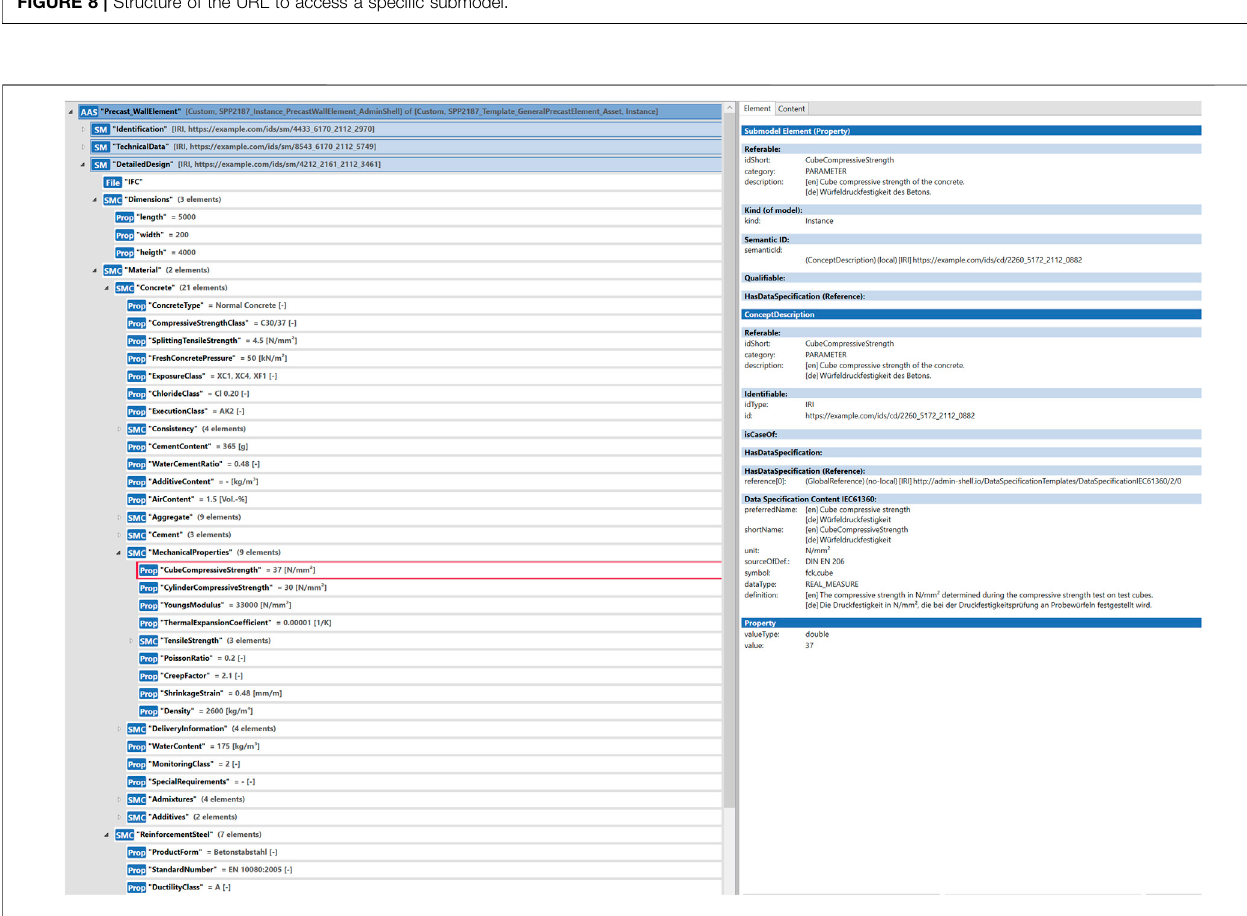
FIGURE 9 | Detailed Design